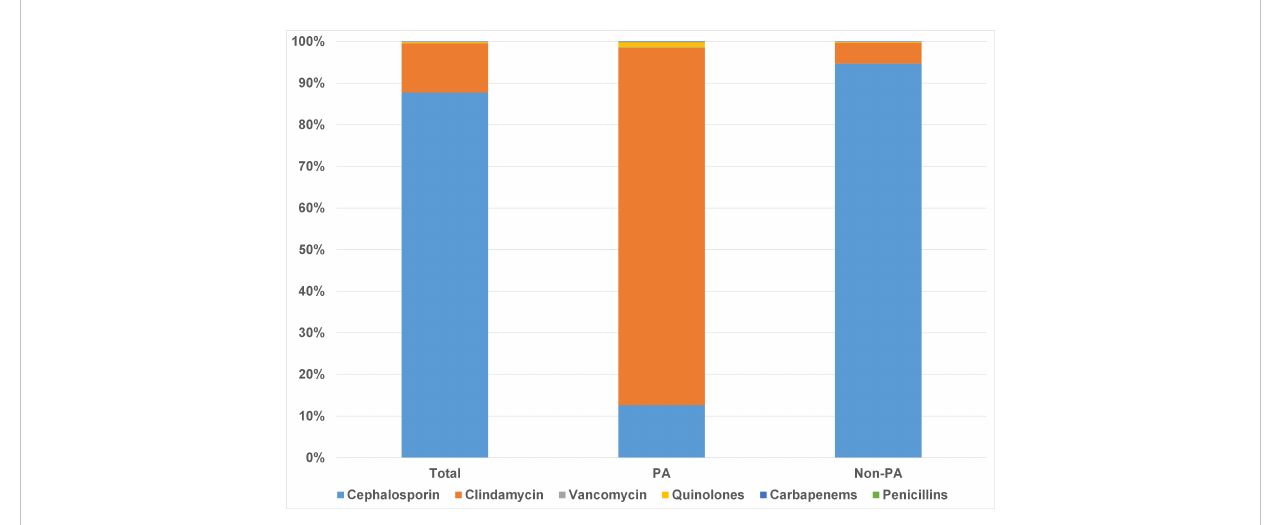
FIGURE 2 Preoperative prophylactic antibiotic regimens in patients with and without penicillin allergy.